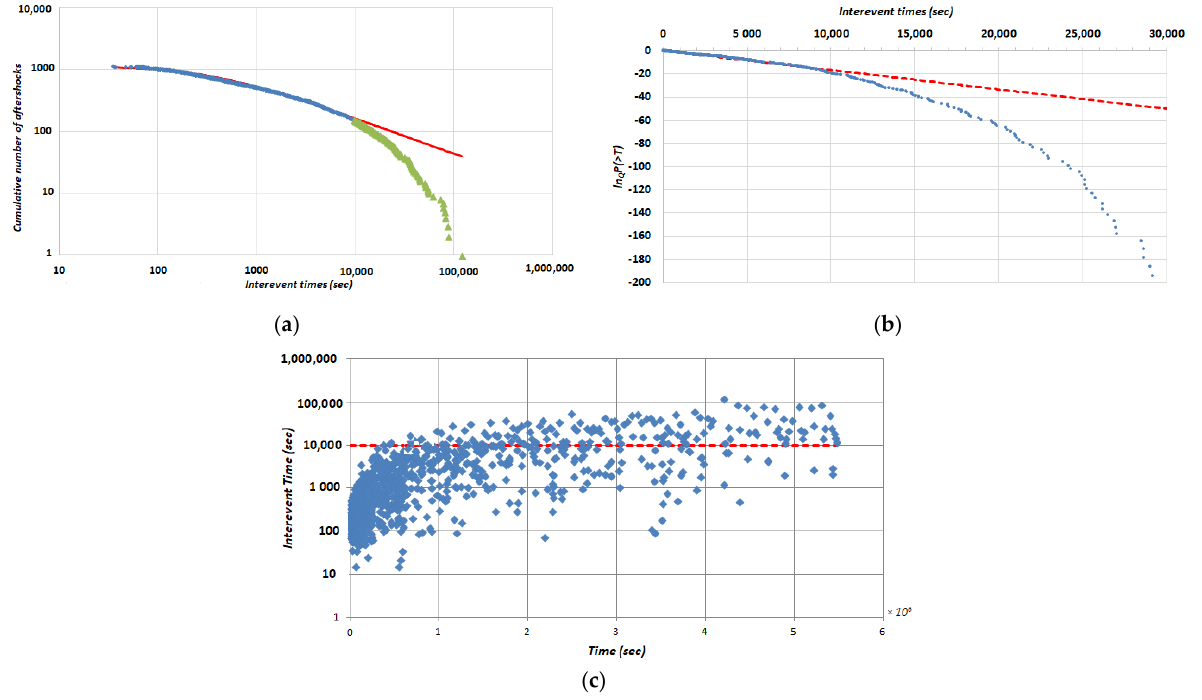
Figure 5. ( a ) The interevent times CDF of the 2020 M w 7.0 Samos Earthquake, for the aftershocks with M > M c . The scarlet solid stroke is the Q -exponential fitting with q = 1.63. The change of colors indicates the crossover between the NESP (blue circles) and BG statistics (green triangles). ( b ) The ln Q P (> T ) as a function of T, where the red line presents the fitting with q = 1.63 and correlation coefficient 0.9942 up to T c . A T c value close to 9761 s is suggested by the deviation from linearity. ( c ) Interevent time T evolution with time t since the main shock. The scarlet line illustrates the T c value.